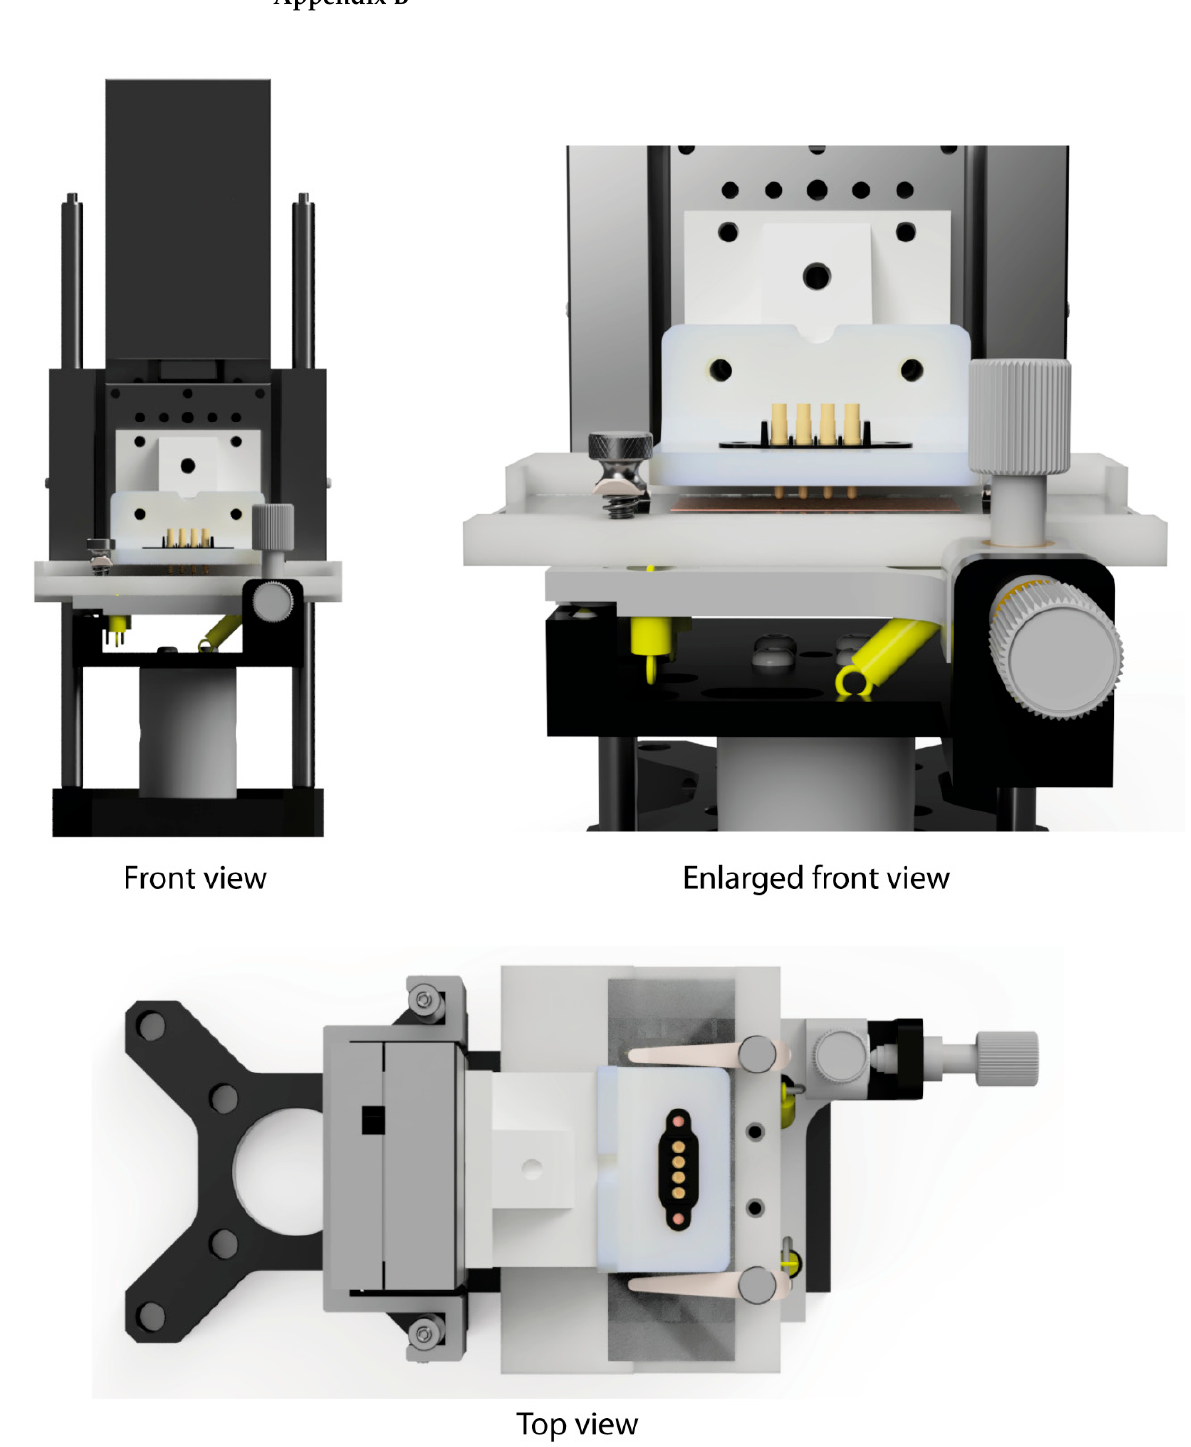
Figure A2. Four-point probe measurement station.